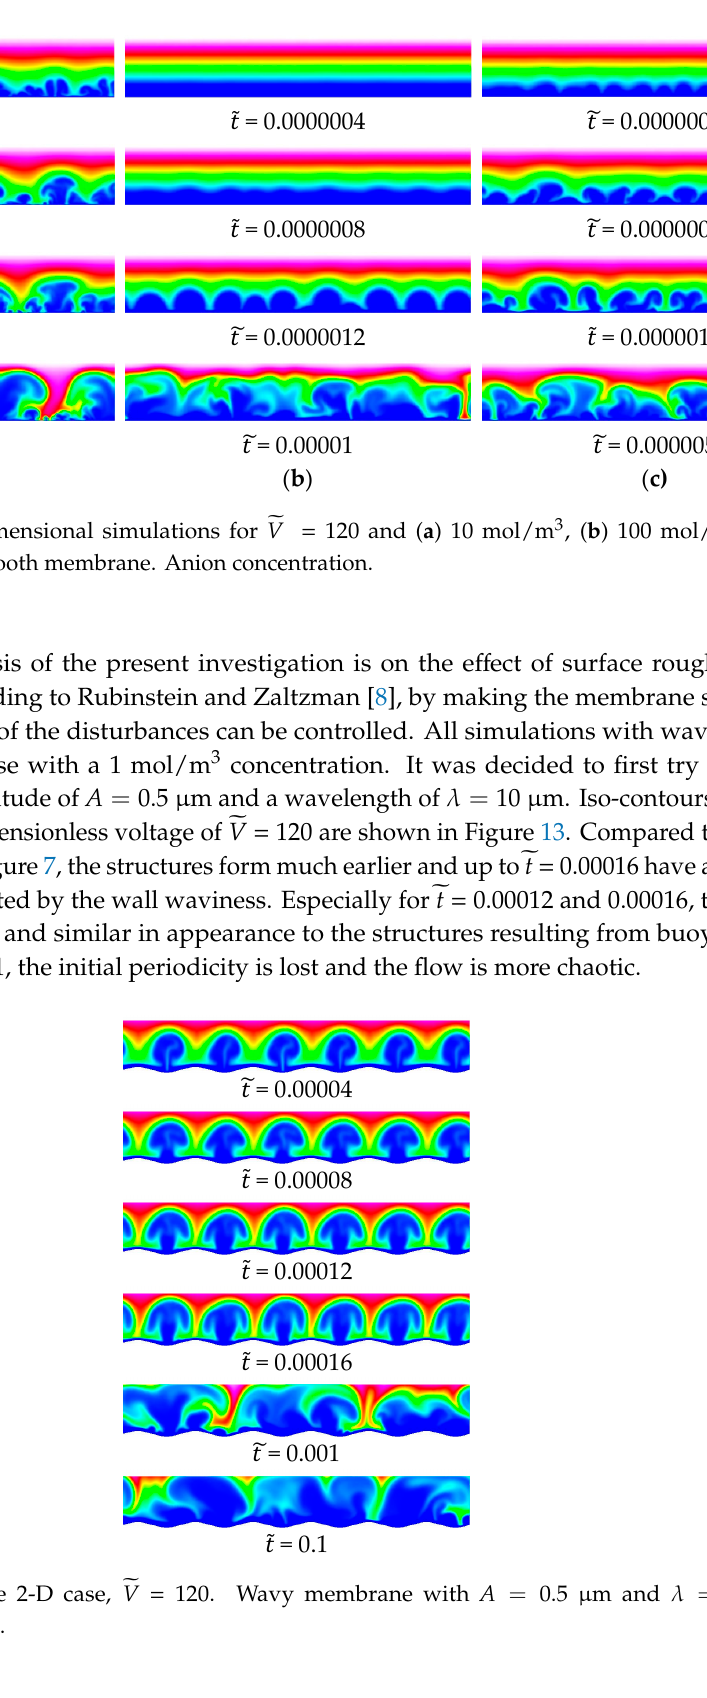
11 of 17 Figure 11. Baseline 2-D case. Time- and area-averaged current density. 4.2. Effect of Salt Concentration The NaCl concentration was raised to 10 mol/m (cid:2871) and 100 mol/m (cid:2871) (simulating slightly and moderately brackish water), and finally 400 mol/m (cid:2871) (seawater). For the medium and high